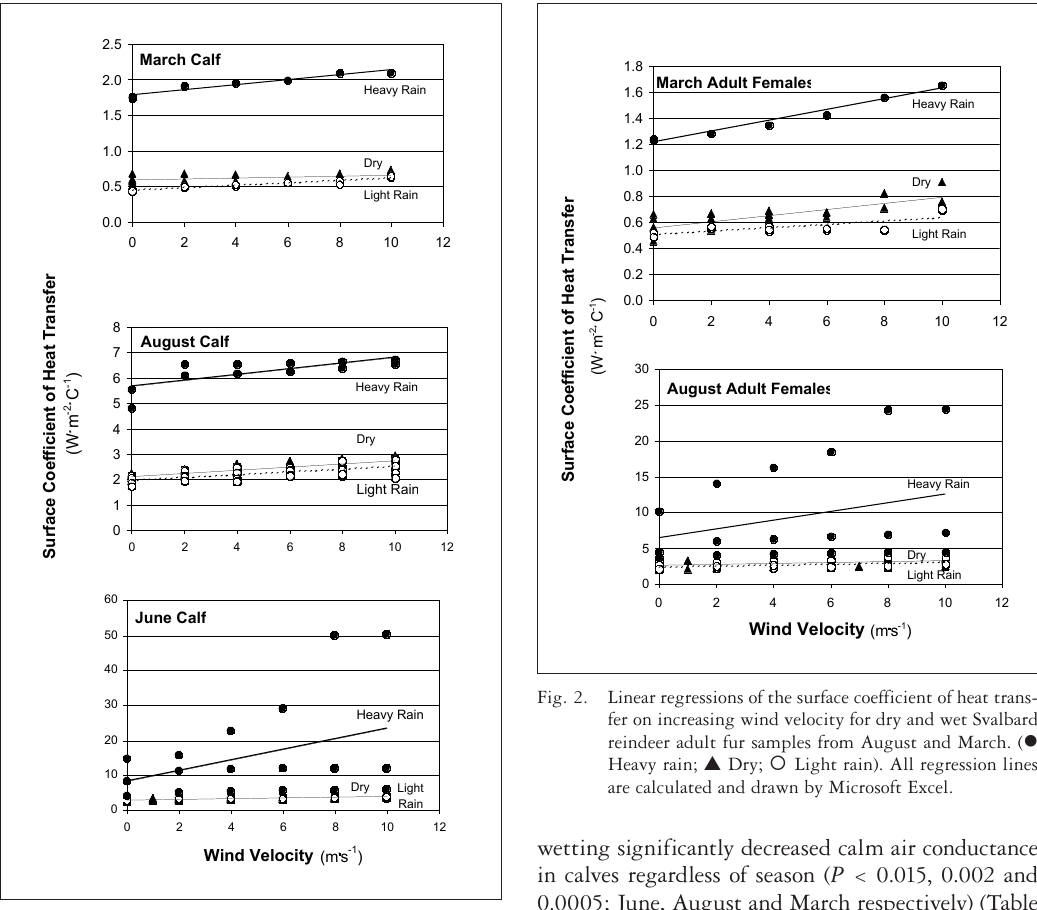
Fig. 2. (NB de to delfigurene skal i ei felles ramme, ikke i adskilte rammer slik som fig. viser. Tegnforklaringen (teksten) til y-aksen må justeres til midten av den totale figuren). Fig. 1. Linear regressions of the surface coefficient of heat trans- fer on increasing wind velocity for dry and wet Svalbard reindeer calf fur samples from June, August and March. ( l Heavy rain; ▲ Dry; ° Light rain). All regression lines are calculated and drawn by Microsoft Excel.